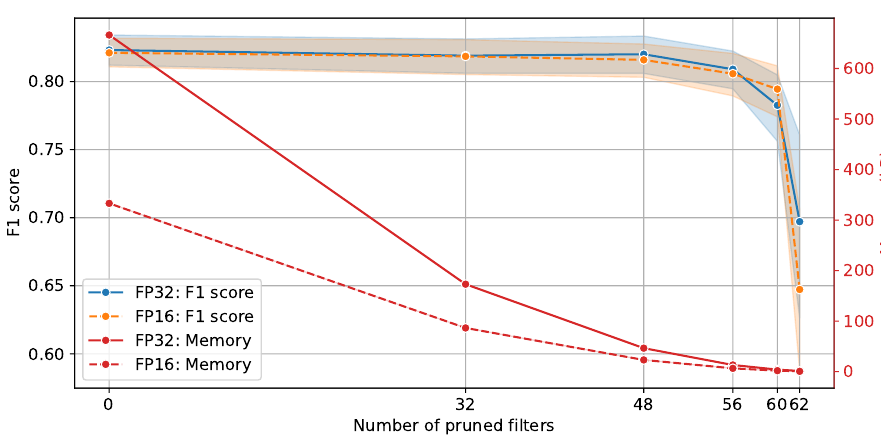
Figure 10. Model performance and memory footprint for different number of